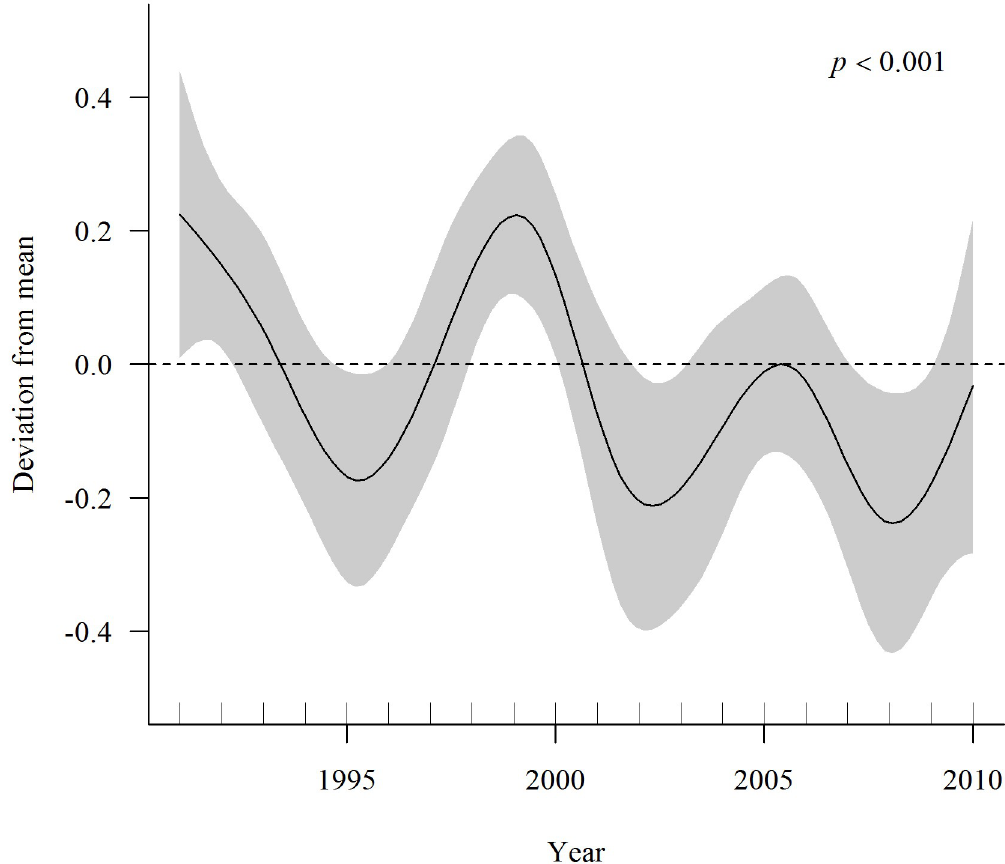
Fig 7. Year effect on fledgling production by goshawks. Expected year effect on fledgling production in 740 breeding attempts by 250 female (combined known-age and hawks aged � 4-year-old on first breeding) northern goshawks from Poisson GAMM of population-level analysis of age-specific reproduction in Arizona, USA. The y-axis shows the deviation from the mean response and the shaded region depicts the 95% CI. The expected year effect on fledgling production by male goshawks (592 attempts by 195 males) was nearly identical to the female